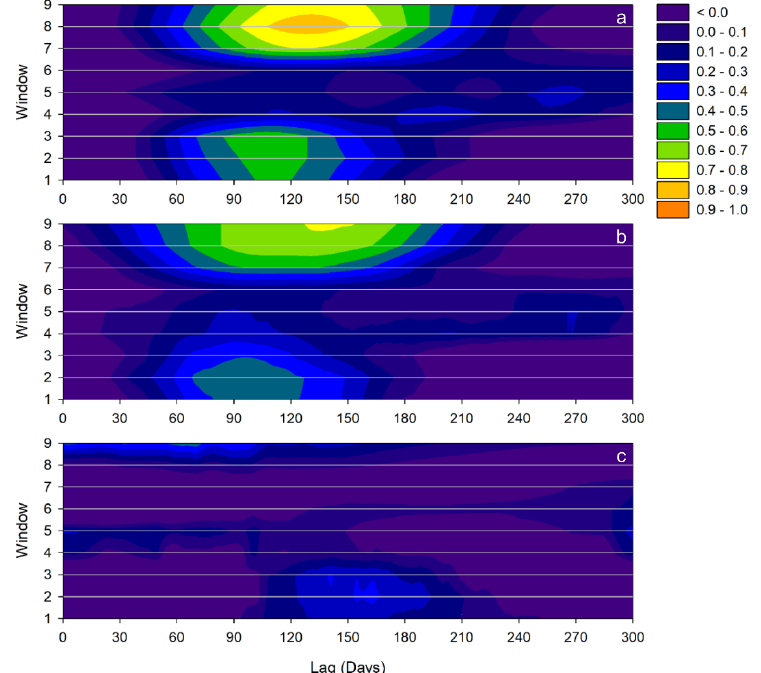
Figure 4. Contour graphs that represent variations in the curve shape of the snow cover/ raw spring discharge CCFs, over the whole period (i.e., among the sliding windows shown in (Table 5). ( a ) MTPs/PES; ( b ) MTPs/CD; ( c ) MTPs/FOC. The positive correlation value corresponding to the 95% significance level ( p < 0.05) is 0.06.